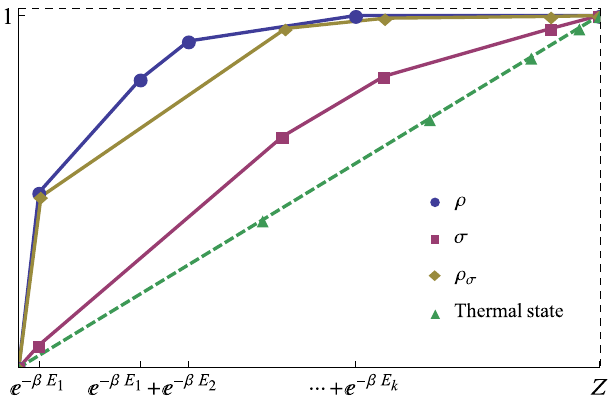
FIG. 5. Here, we illustrate the construction of the state ρ σ used in the proof of Theorem 4. The points of the curve ρ that are at the same horizontal position as the elbows of σ are joined, and by concavity the resultant curve is always below ρ